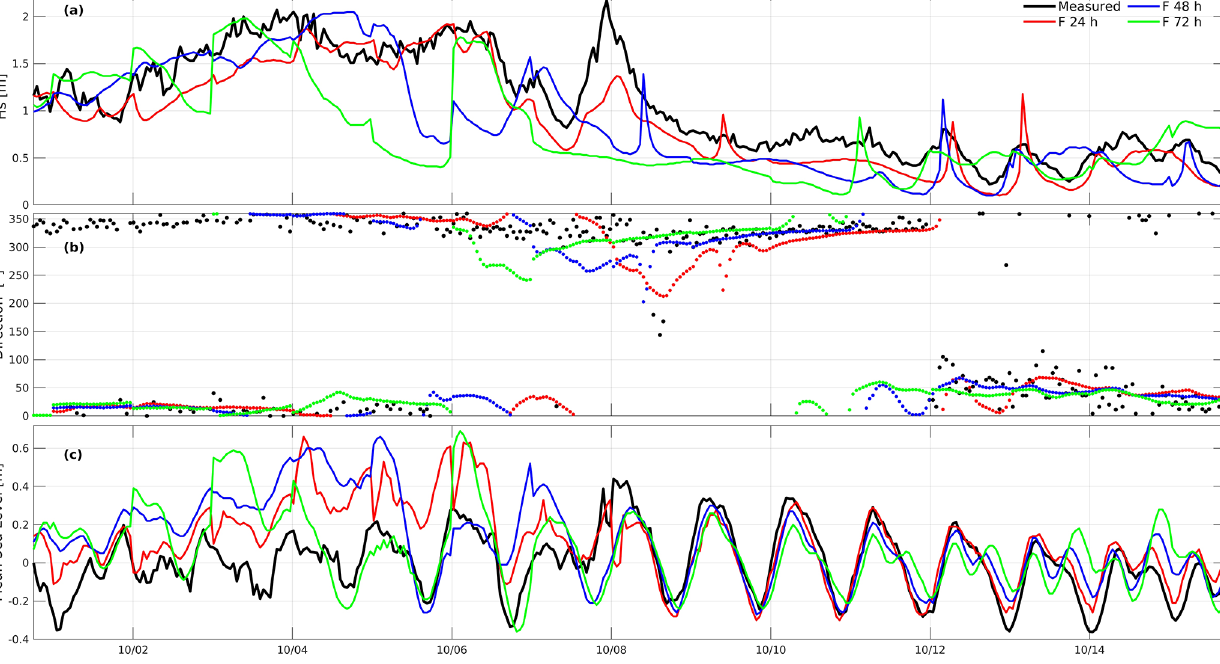
Nat. Hazards Earth Syst. Sci., 22, 4063–4085, 2022